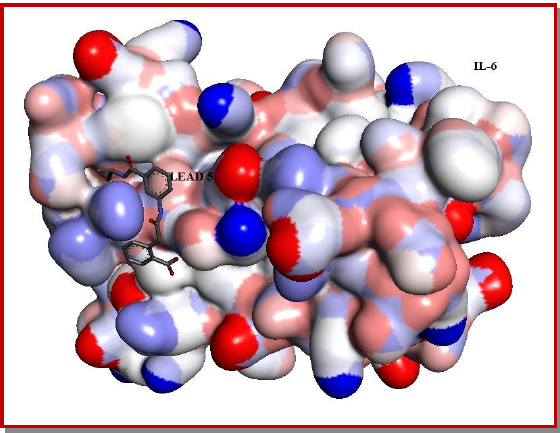
Figure 1: Step wise illustration of the Modus operandi in use